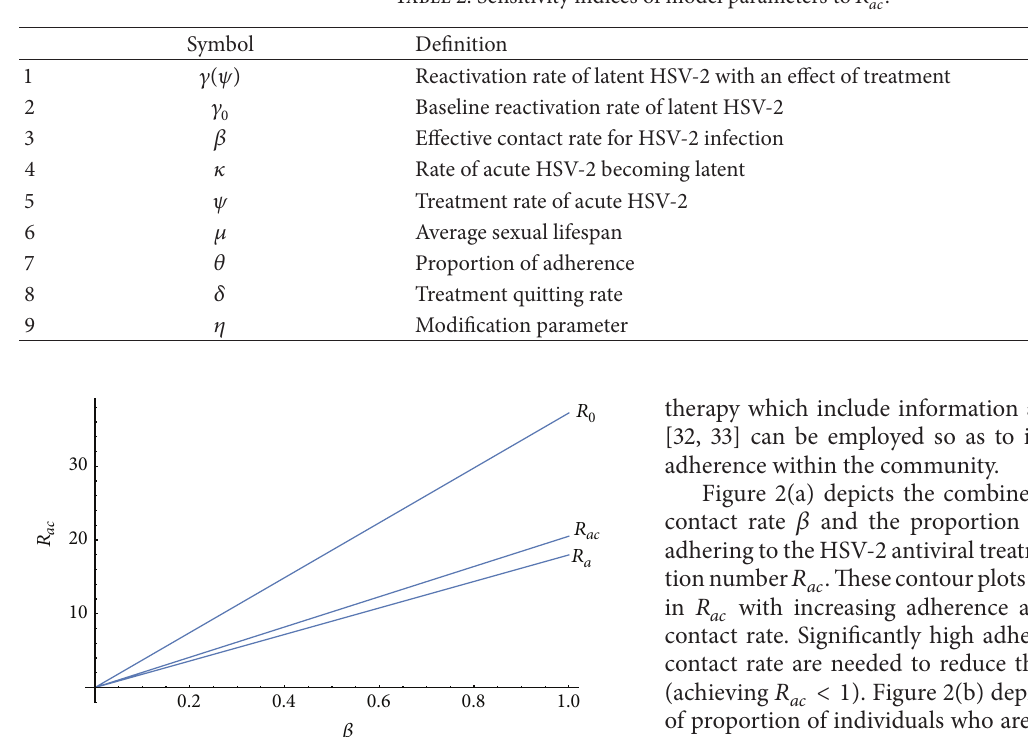
Table 2: Sensitivity indices of model parameters to 𝑅 𝑎𝑐 .